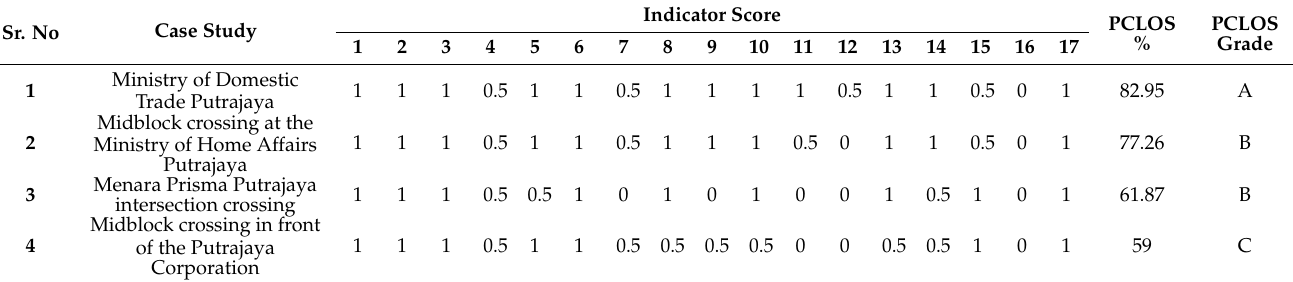
Table 6. Summary of results for calculating the